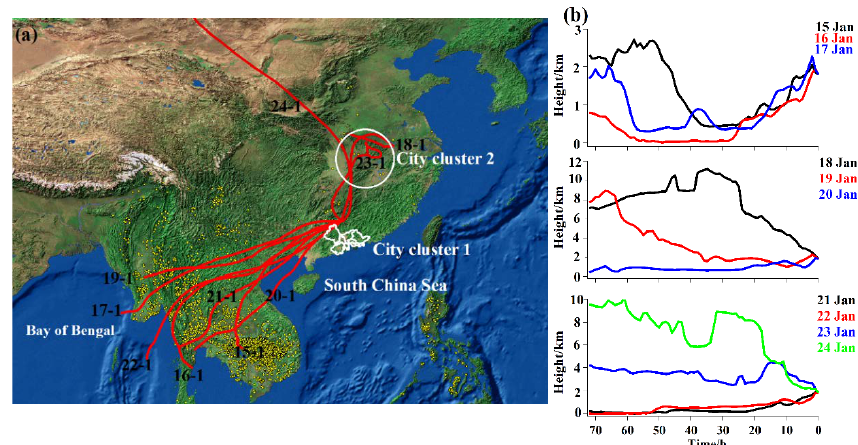
Figure 2. (a) HYSPLIT back trajectories (72h) for air masses at 1800m during the whole sampling period. The white borders and circle refer to the Pearl River Delta (city cluster 1) and Yangtze River mid-reach city clusters (city cluster 2), respectively. The fire data (yellow dots) are available at https://earthdata.nasa.gov/; (b) heights (above sea level) of the air masses as a function of